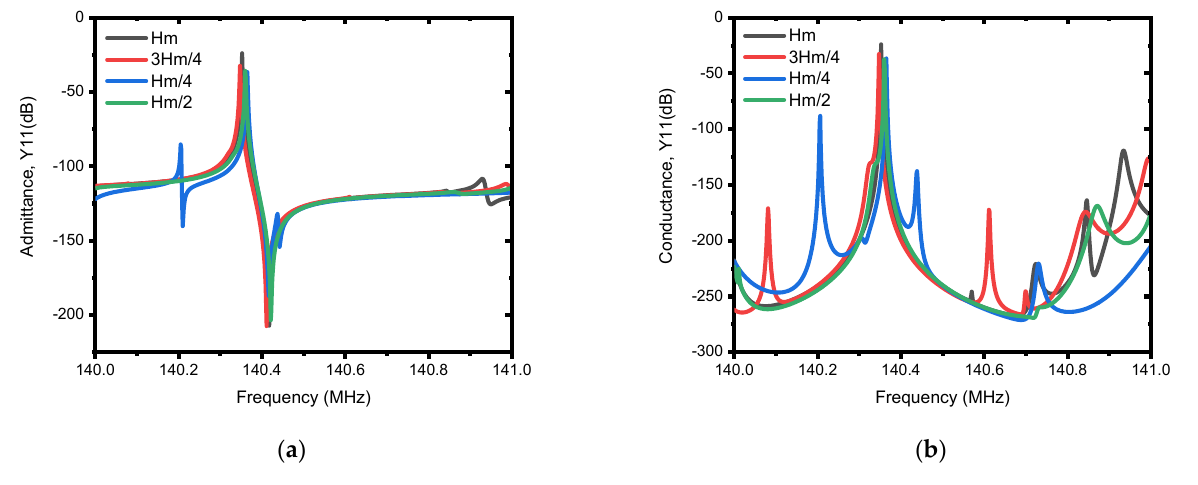
Figure 11. Illustration of simulated electrical responses using different patch depths (i.e., H m /4, H m /2, 3 H m /4, and H m ). The patch depth ( L patch ) of W e /3 and the patch metal of tungsten (W) are used for the simulation. ( a ) Admittance, Y11 (dB), and ( b ) conductance, G (dB).